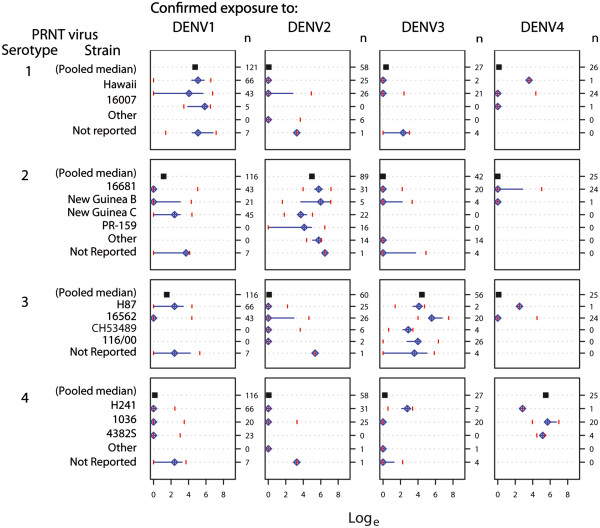
Matrices of natural logarithm-transformedPRNT titers from primaryDENV exposures stratified bystrain. The “n” on the upper right of each exposure column represents the number of titers, filled squares indicate the pooled median log titer for all strains within that particular box, diamonds with crosshairs represent median log titers for strains, horizontal lines span the 25th-75th percentiles (interquartile range), and vertical lines mark the 5th and 95th percentiles of the data.